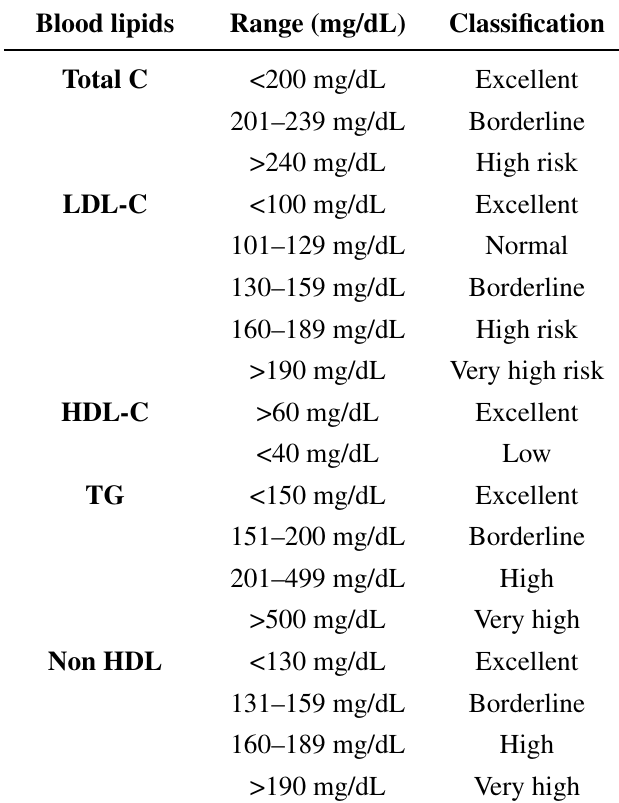
Table 10. Classification of Cholesterol and Triglycerides by Brazilian Cardiology